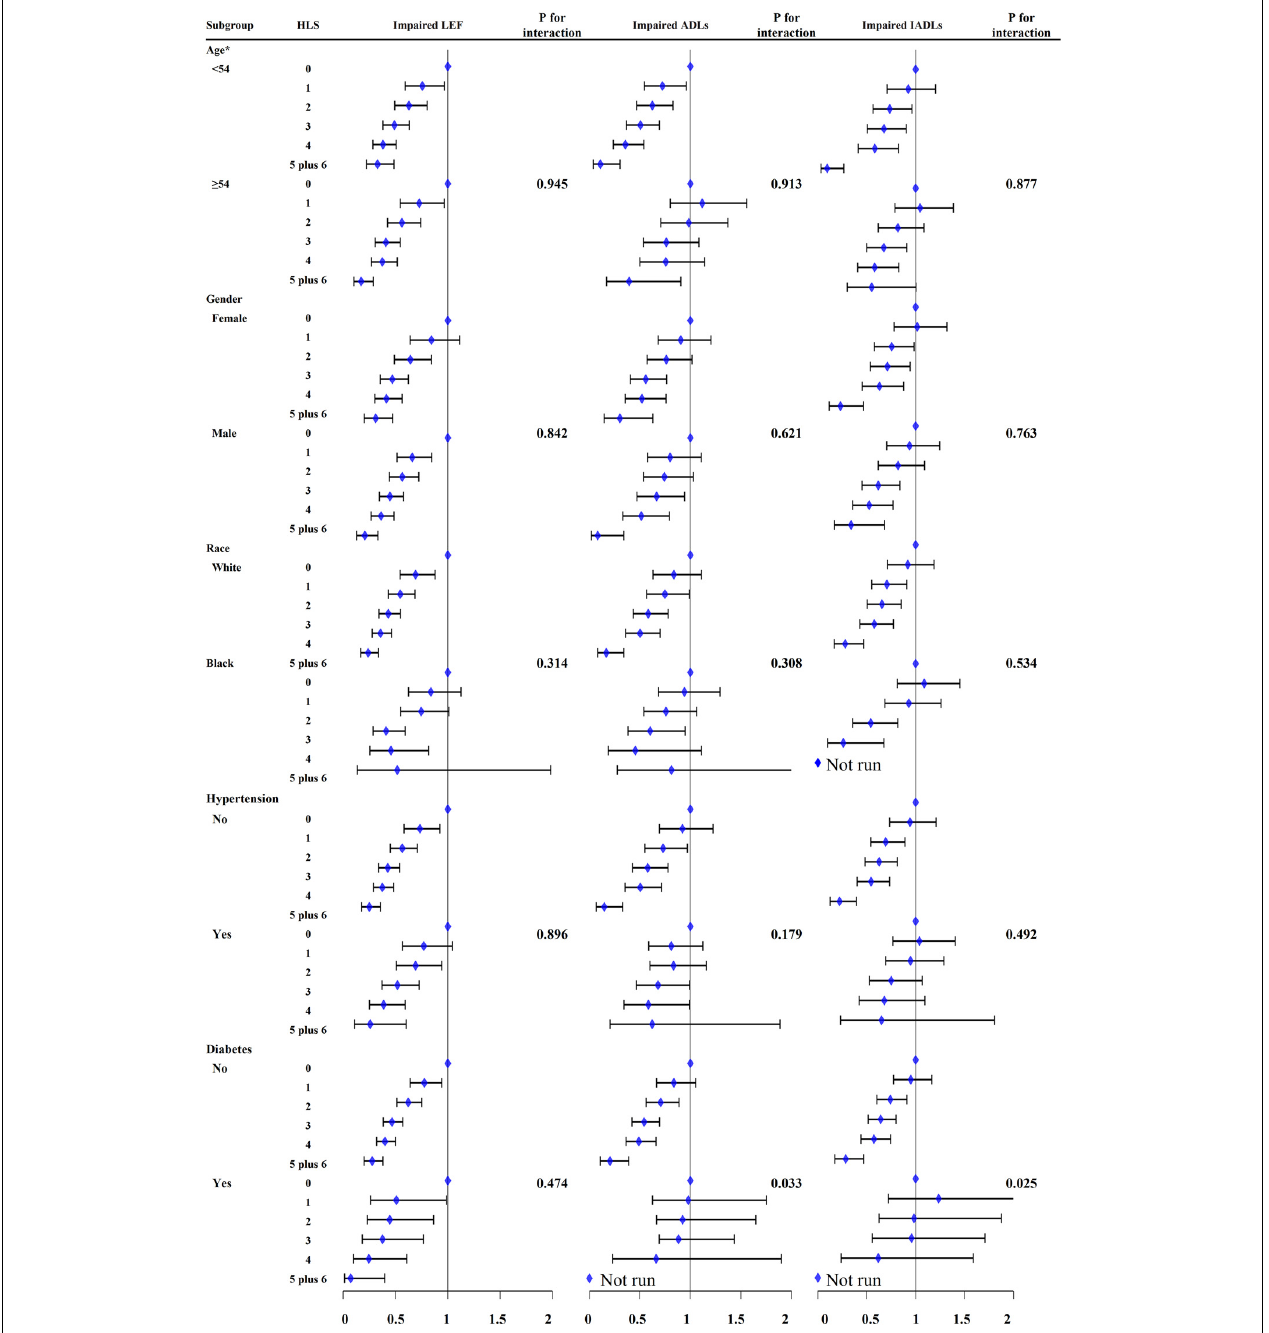
FIGURE 3 | The association between healthy lifestyle score (HLS) with impaired lower-extremity function (LEF), activities of daily living (ADLs), and instrumental ADLs (IADLs) in the subgroup of age, sex, race, hypertension, and diabetes. Some models cannot run because of the very low sample size. Age was divided by median. Multivariable Logistic regression models were adjusted by age, sex, center-race, education ( < high school, high school, or >high school), annual household income ( < 16,000, 16,000–35,000, > 35,000), total calorie intake, total cholesterol, high density lipoprotein, low density lipoprotein, triglycerides, creatinine, blood glucose, hypertension, coronary heart disease, and diabetes. CI, confidence interval. OR, odd